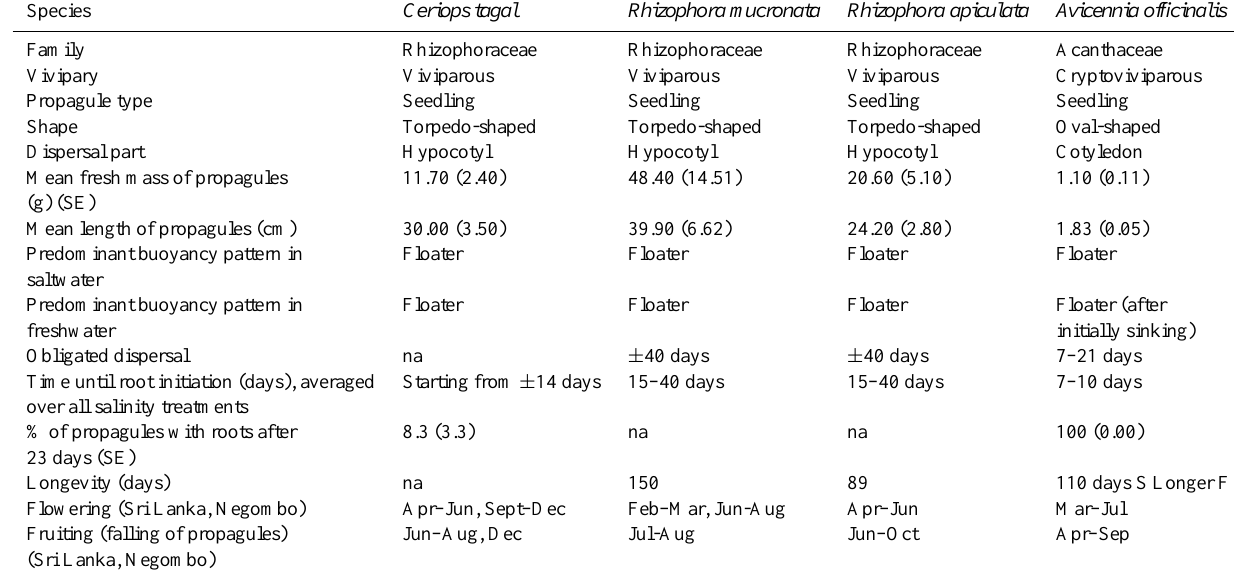
Table 1. Propagule dispersal characteristics of the species Ceriops tagal , Rhizophora mucronata, R. apiculata and Avicennia officinalis (e.g. Clarke, 1993; Clarke Peter et al., 2001; Drexler, 2001; Rabinowitz, 1978). S = salt water, F = fresh water, na = data not